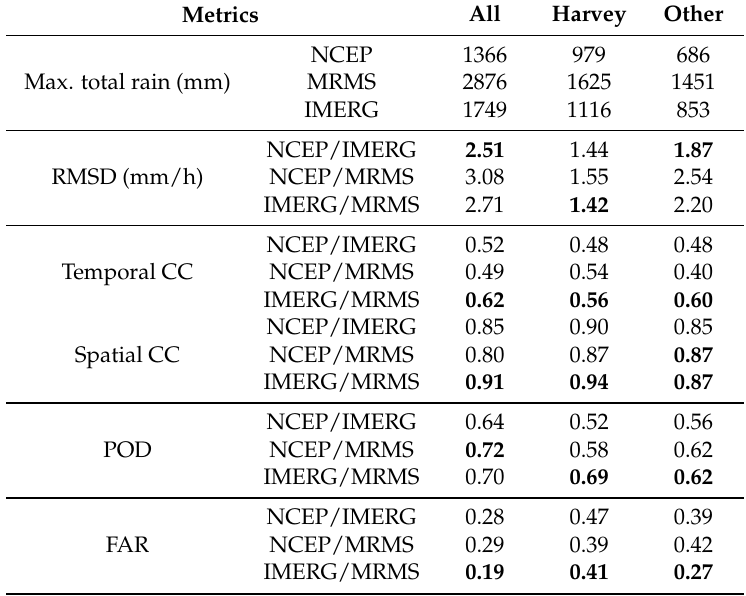
Table 3. Overall conventional statistics for three cases (i.e., All, Harvey, and Other) and pairs of